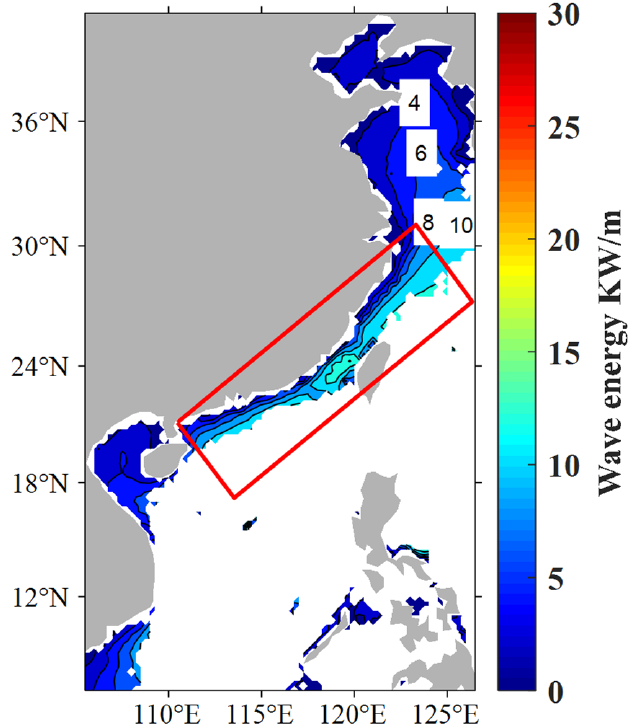
Figure 14. The distribution of annual mean P w in the selected area.